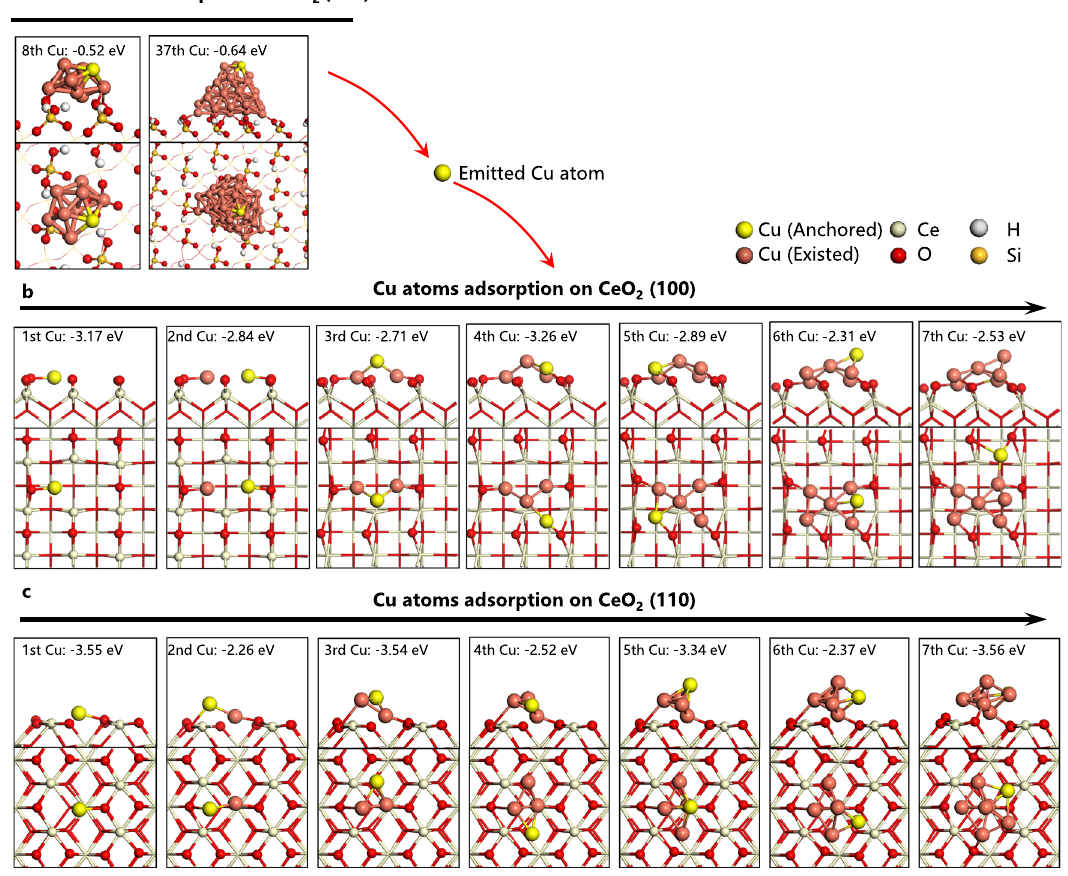
Fig. 4 | The formation process of Cu clusters during ordered atomic diffusion investigated by DFT study. a Cu adsorption energies on Cu clusters and NPs on SiO 2 . b , c The most stableadsorptionpositionsof Cu atoms onCeO 2 (100)( b )and